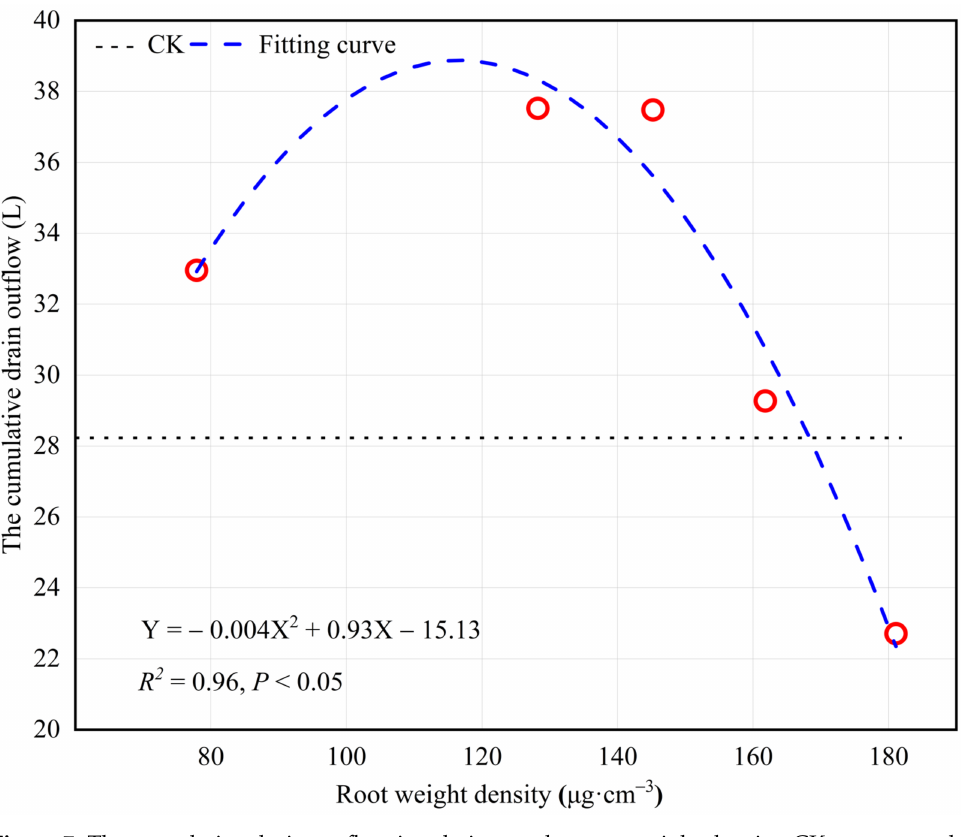
Figure 7. The cumulative drain outflow in relation to okra root weight density. CK represents the value corresponding to bare land. Data are the means of four